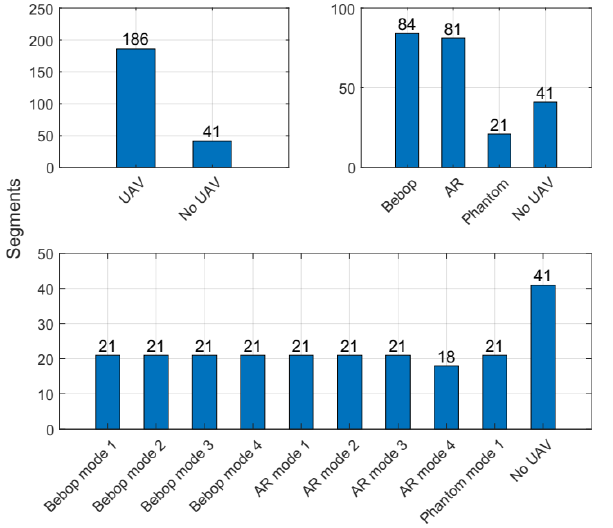
Figure 2. Segments for each set of classes (2, 4, and 10) at each experiment level in the public Radio Frequency (RF)